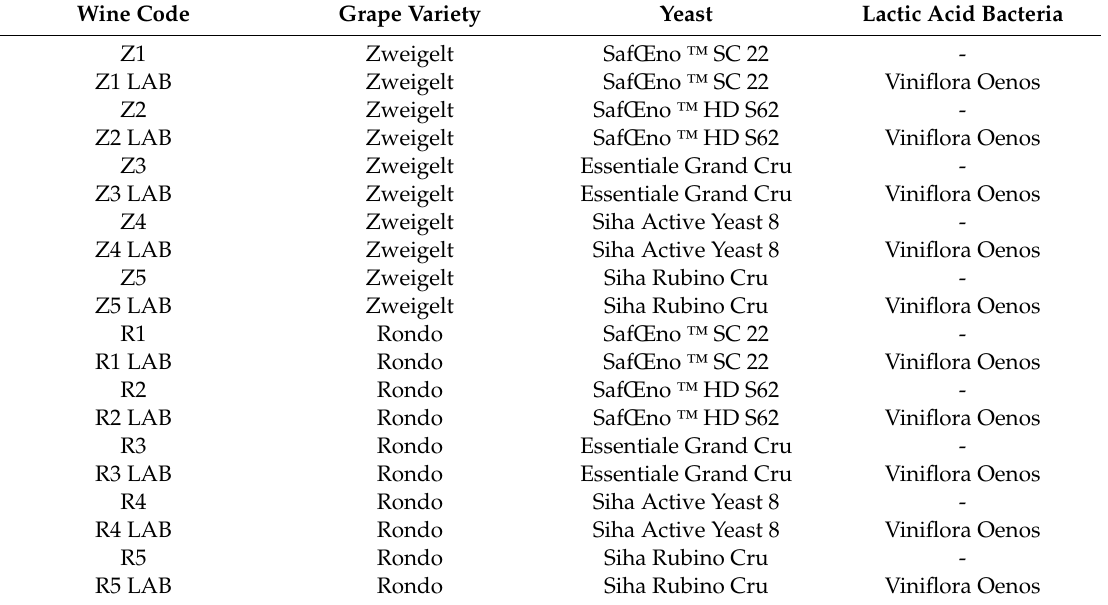
Table 2. Description of wine